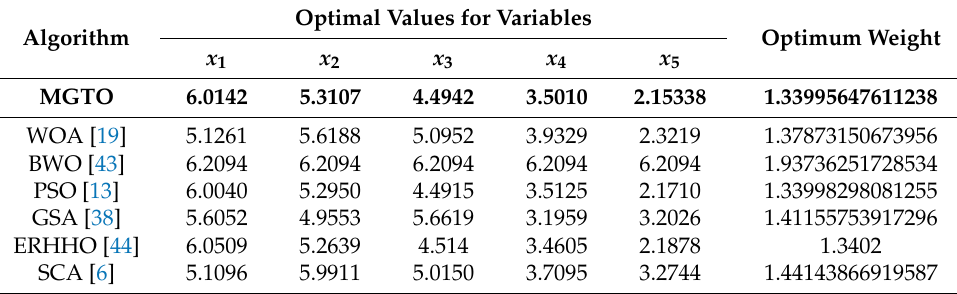
Table 13. Experimental results of the cantilever beam design problem test.